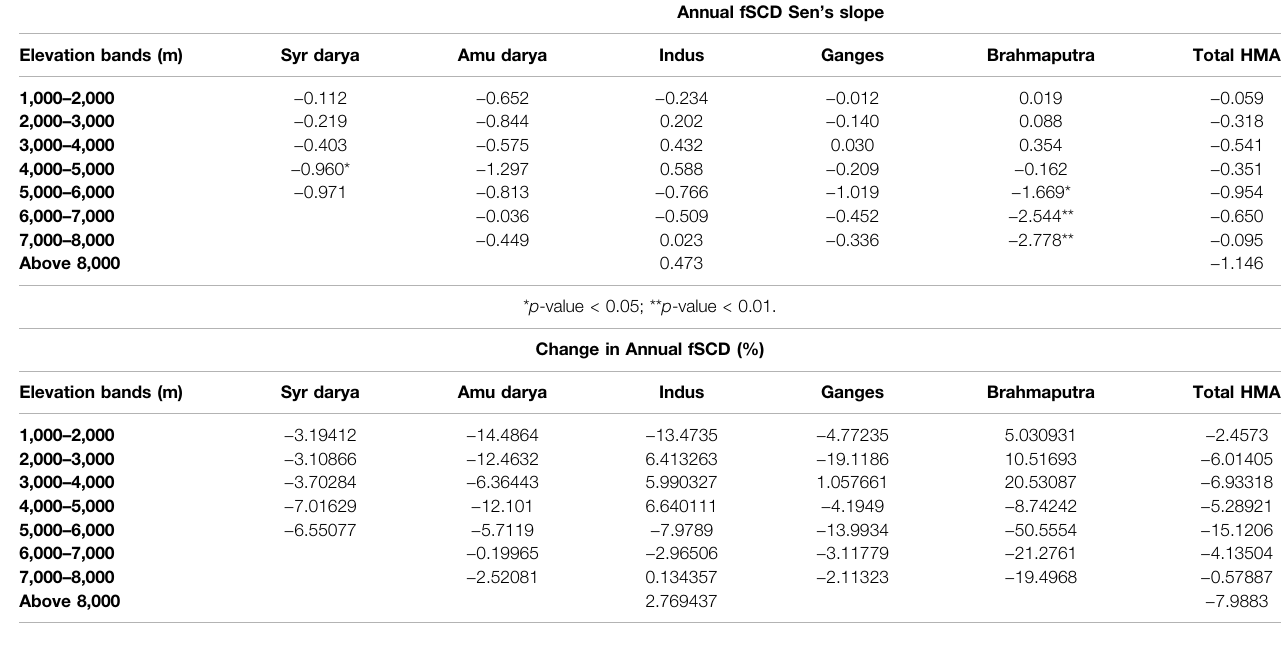
TABLE 3 | Slope of annual fSCD per elevation band for each basin and the total HMA region, including the percent change in annual fSCD.